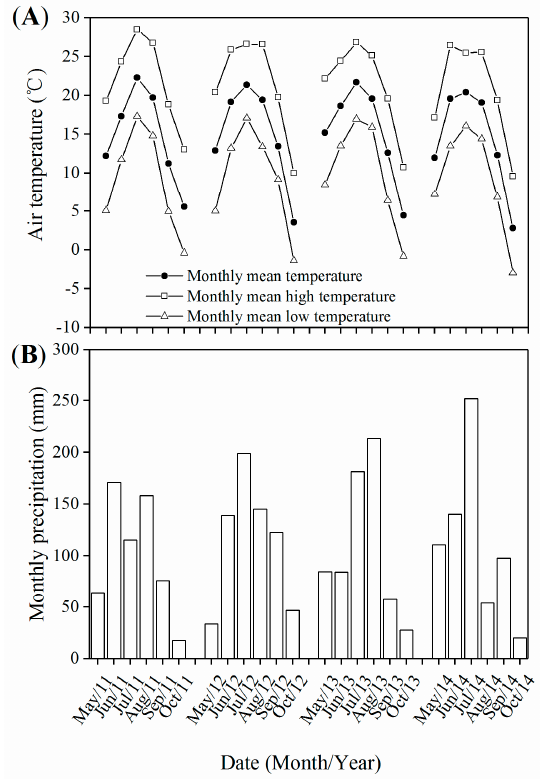
Figure 1. Monthly air temperature ( A ) and precipitation ( B ) from May to October 2011–2014. Among the observed years, the seasonal variations in the thawing depth, water table levels, and soil temperature at 10 cm depths were similar (Figure 2). The active layers peaked at the end of the growing season (Figure 2A). The soil temperatures peaked in July or August (Figure 2B). The water tables dropped to the lowest level of the year during the short drought period from June to July (Figure 2C). During the four investigated years, the maximum active layers were 65.2–90.0 cm, 110.8–138.0 cm, and 141–165.2 cm in the no-thawing, mild-thawing, and severe-thawing sites, respectively (Figure 3A). Seasonal mean water tables were − 11.2 cm, − 6.9 m, and 14.0 cm in no-thawing, mild-thawing, and severe-thawing sites, respectively (Figure 3B). Seasonal mean soil temperatures at a depth of 10 cm were 5.9 ◦ C, 7.3 ◦ C, and 10.5 ◦ C in the no-thawing, mild-thawing, and severe-thawing sites, respectively (Figure 3C). Dominant plants shifted from trees/shrubs to herbs because of the permafrost thawing. The herb aboveground biomasses were 23.5, 111.0, and 445.2 gm − 2 in permafrost no-thawing, mild-thawing, and severe-thawing sites, respectively (Figure 3D).